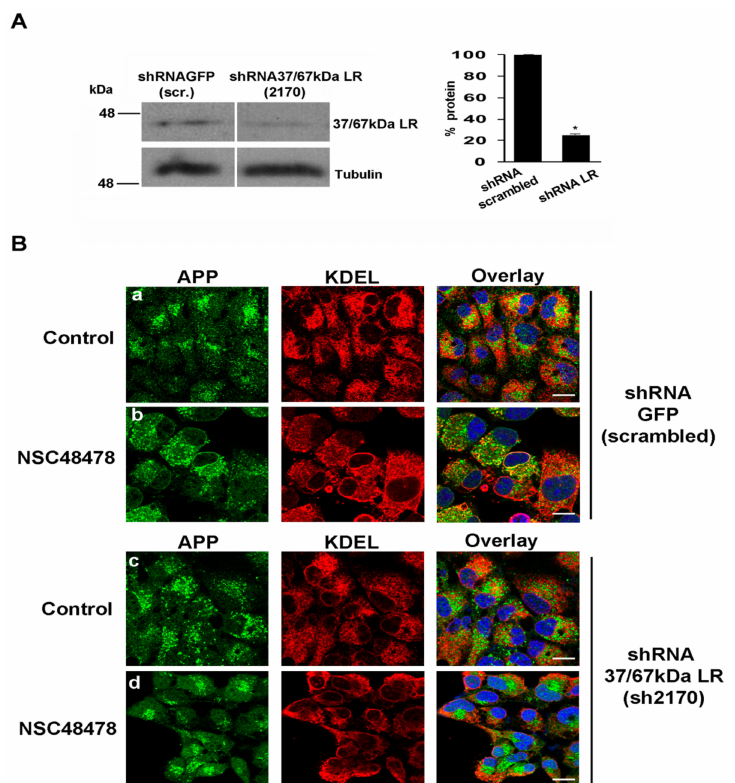
Figure 10. Downregulation of 37 / 67 kDa LR by short hairpin RNA, hampers the e ff ects exerted by the inhibitor. ( A ) 37 / 67 kDa LR was silenced using a specific shRNA (mouse shRNA 2170) for 48 h. In comparison to shRNA 37 / 67 kDa LR (mouse shRNA 2170), 35 µ g of total cell lysate from control cells (non-targeting RNA, shRNA GFP, scrambled) were loaded for reference. Membranes were probed with anti-37 / 67 kDa LR antibody to reveal the receptor. The same membranes were probed with anti-tubulin antibody followed by ECL. The amount of silenced receptor was quantified from three independent experiments (* p < 0.05). ( B ) Immunofluorescence analysis of scrambled or receptor silenced cells was conducted to analyse the e ff ects of NSC48478 on APP localization. The cells were processed as in Figure 4. Colocalization analysis has been described in the methods section. Scale bars, 10 µ